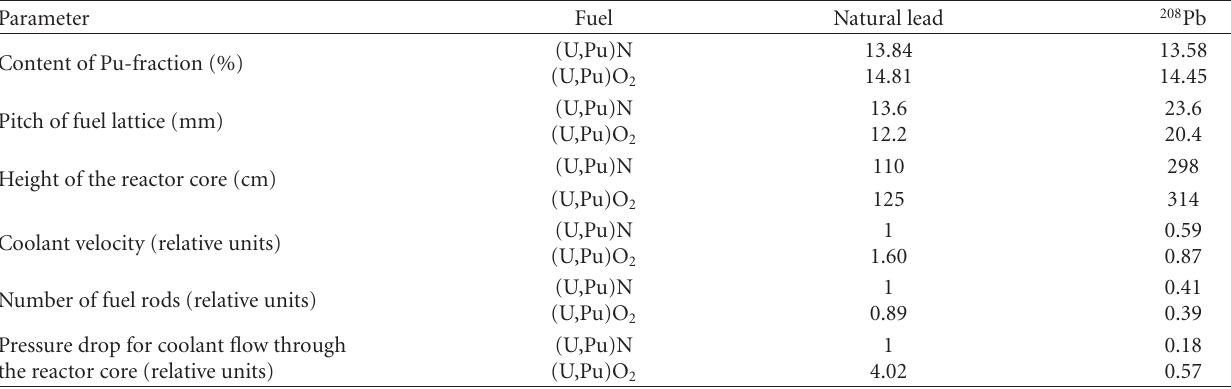
Table 5: Transition from (U,Pu)N-fuel to (U,Pu)O 2